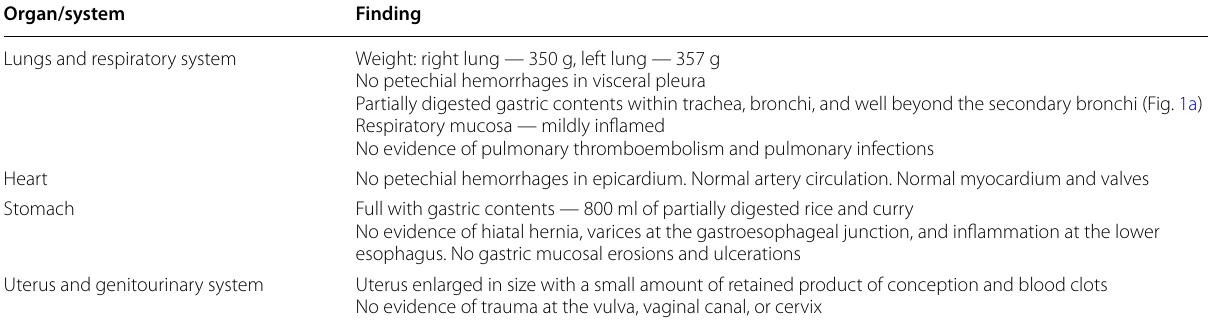
Table 1 Specific autopsy findings Organ/system